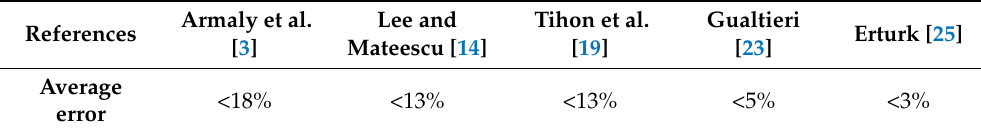
Table 8. Average errors (%) between numerical results of the reattachment lengths with literature data.